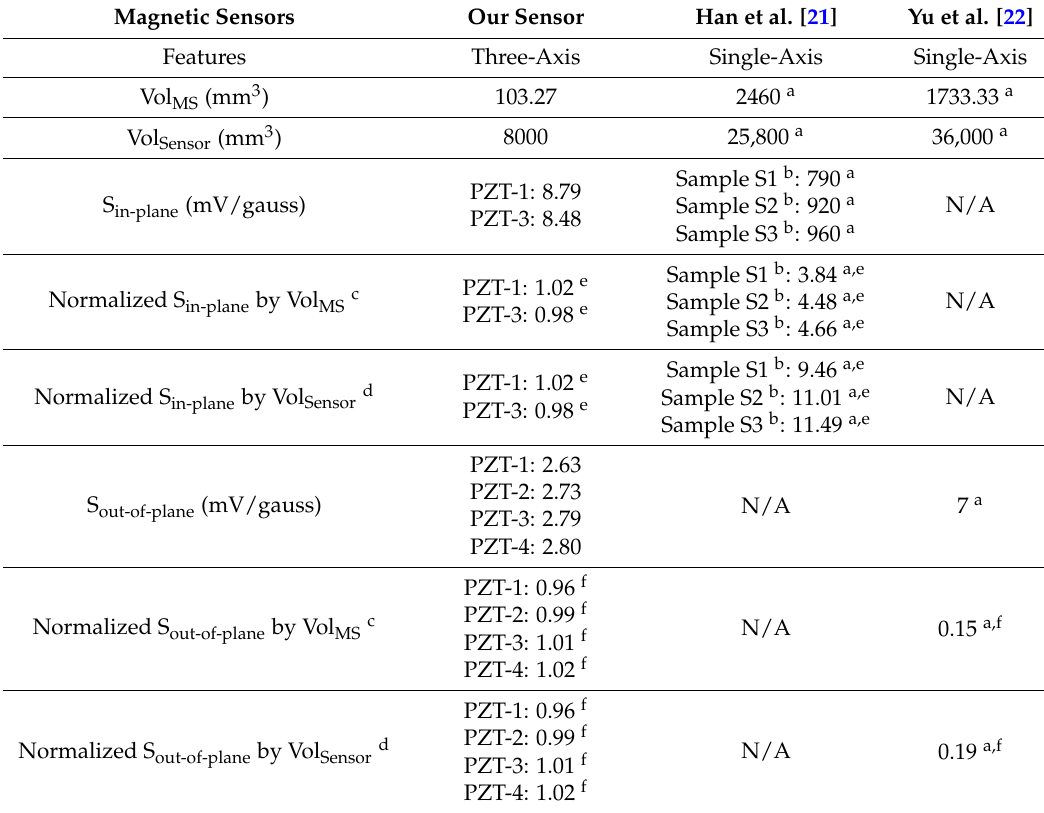
Table 2. Comparison of the sensitivity of our, and other representative, magnetic-force-interaction- based magnetic